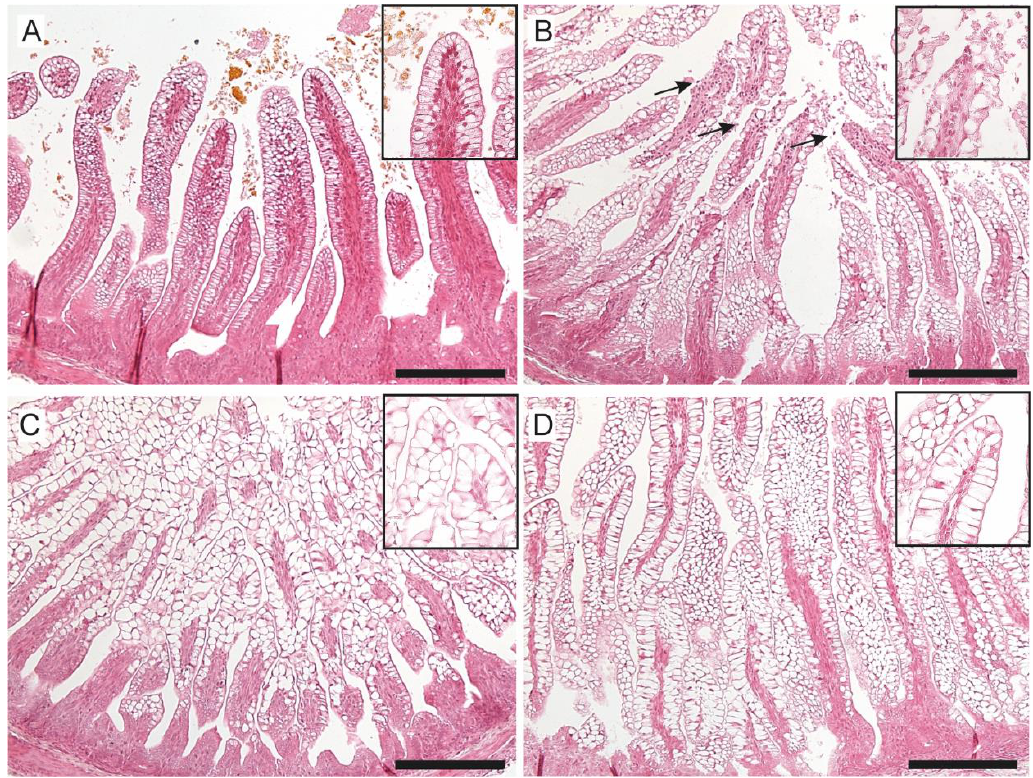
Figure 7. Evaluation of morphological changes and enterocyte vacuolization in the distal ileum of preterm lambs by H&E staining in control (A) , UP-exposed (B) , UP + carrier-exposed (C) , and UP + sterol + carrier-exposed fetal lambs (D) . Injury of the villi tips (arrows) was observed after 6 d UP exposure, which was prevented by carrier and/or sterol + carrier treatment. The size of the vacuoles within the enterocytes was increased in all experimental groups and most profoundly in UP + carrier and UP + sterol + carrier animals. Scale bar indicates 200 µm. Abbreviations: H&E, hematoxylin and eosin; UP, U. parvum